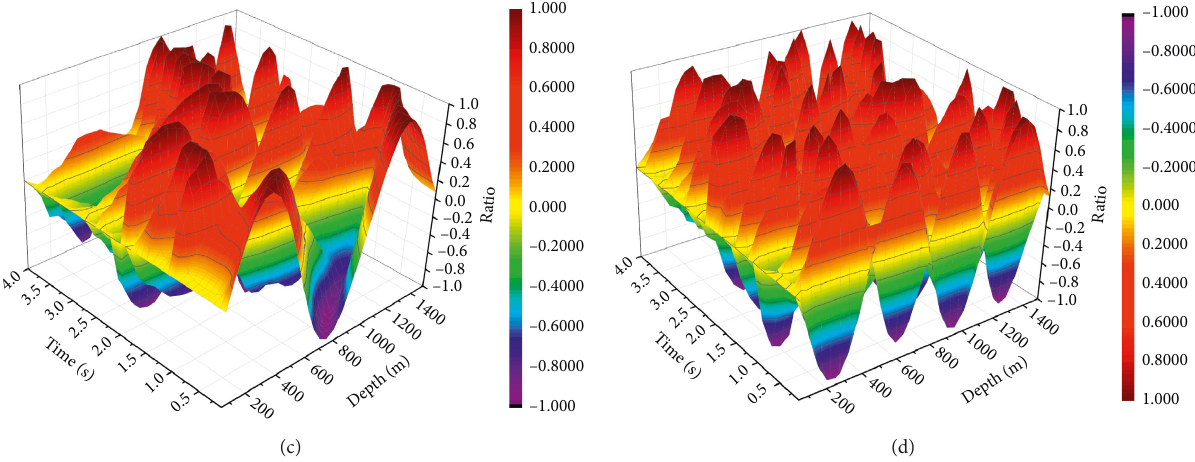
Figure 7: The first four order modes of vibration with time 0s ∼ 4s: (a) first order; (b) second order; (c) third order; (d) fourth order.